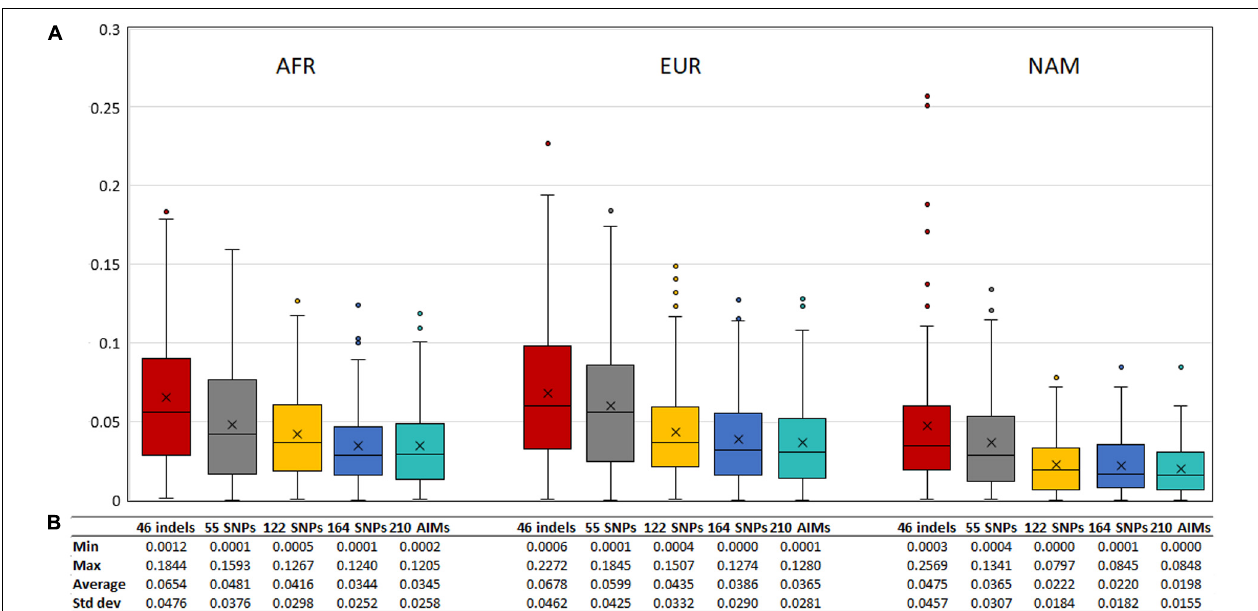
FIGURE 11 | (A) Box and whisker plot of the absolute differences between the ancestry estimated in the 130 offsprings and the average ancestry of the parents with the five AIM sets. The box represents the interquartile range between the first and the third quartiles. Line in the box displays the median value and the x displays the mean value. Whiskers define 1.5 times the interquartile range. (B) The minimum, maximum, average values, and the respective standard deviations are also presented for each panel and